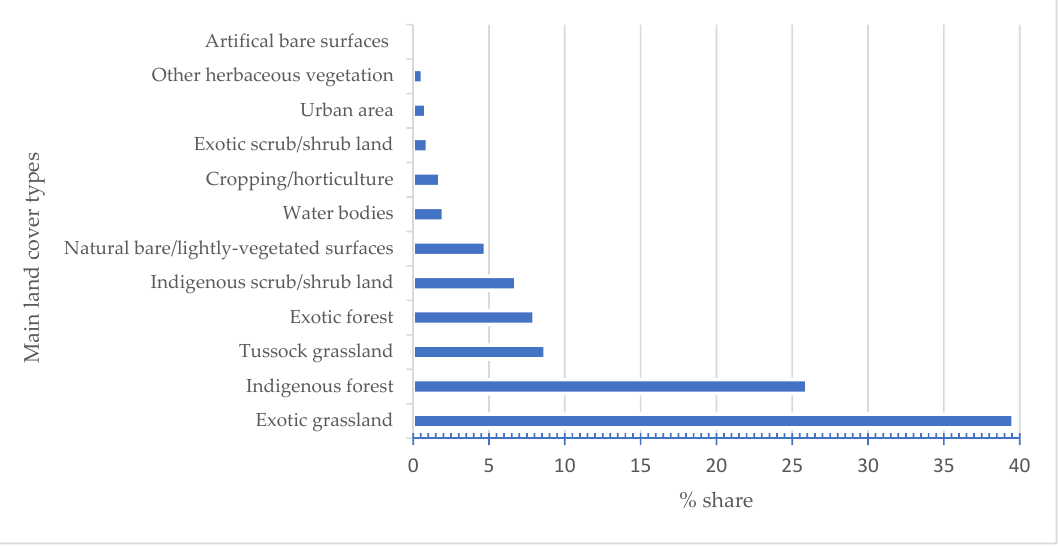
Figure 2. The percentage share of NZ total land area by main land cover types in 2012. (This work is based on/includes Stats NZ’s data which are licensed by Stats NZ for reuse under the Creative Commons Attribution 4.0 International licence [21]).